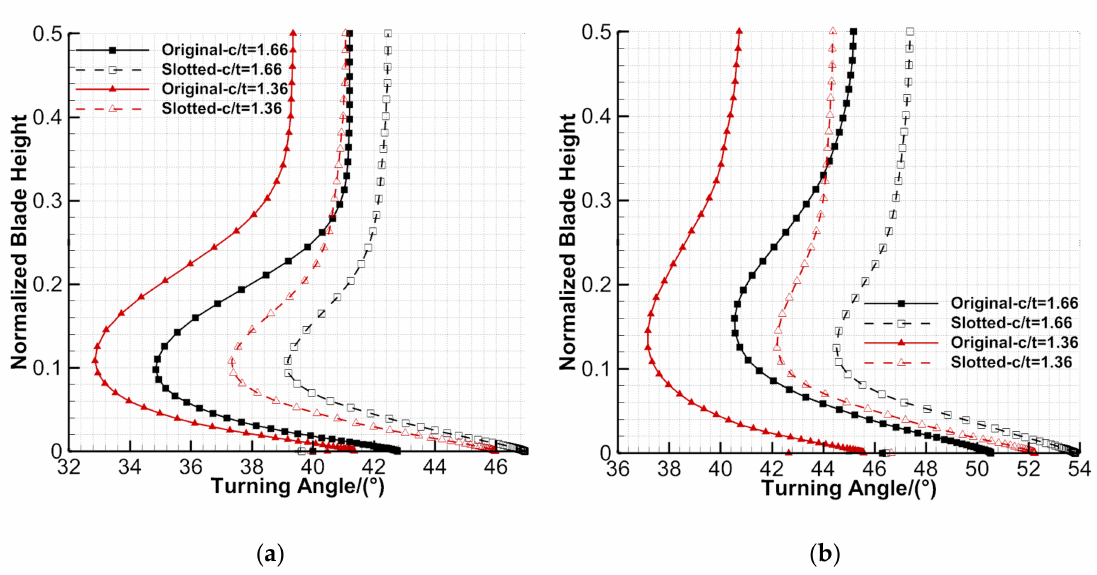
Figure 13. Pitch-averaged turning angle distributions along the blade span of the original cascade and combined slotted cascade: ( a ) 0 ◦ ; ( b ) 6 ◦